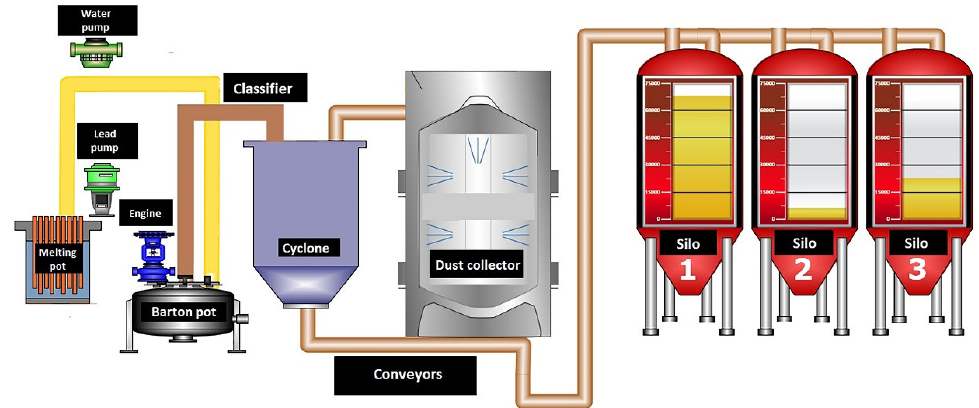
Figure 2. Schematic of the Barton reactor (screen from the control program in AUTOPART— Mielec, Poland).